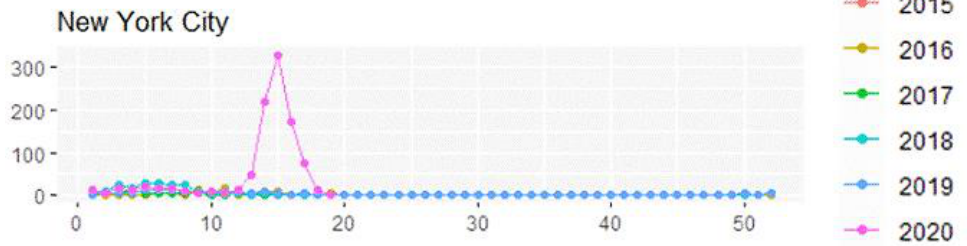
Figure 2. Weekly influenza mortality recorded in New York City broken down by years